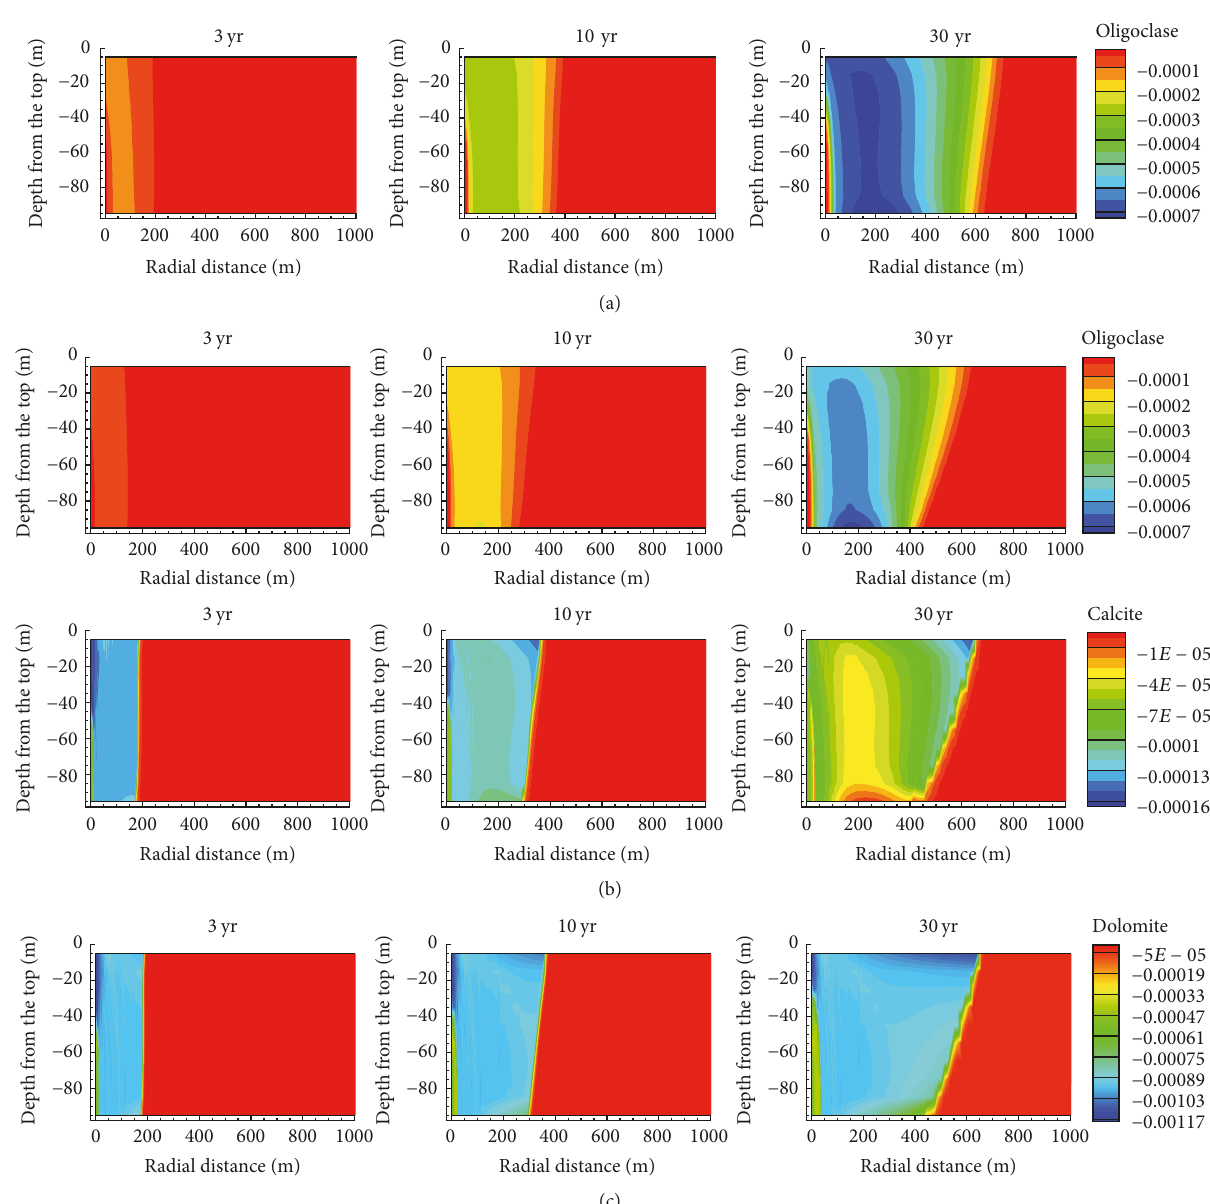
Figure3:Temporalandspatialevolutionofthekeymineralsvolumefractioninthethreeformations((a)Liujiagouformation;(b)Shiqianfeng formation; (c) Shihezi formation).